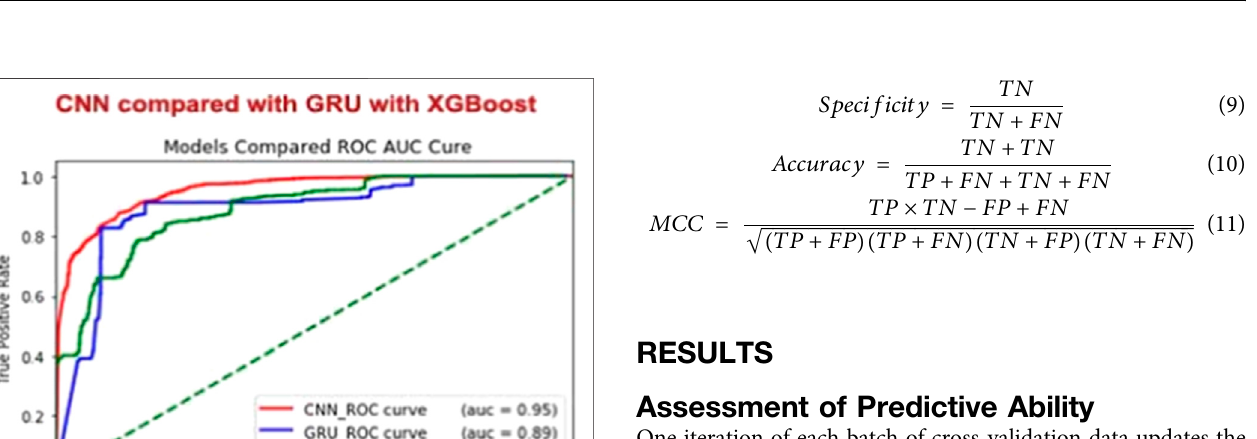
FIGURE 3 | CNN model ROC (AUC), precision and recall.